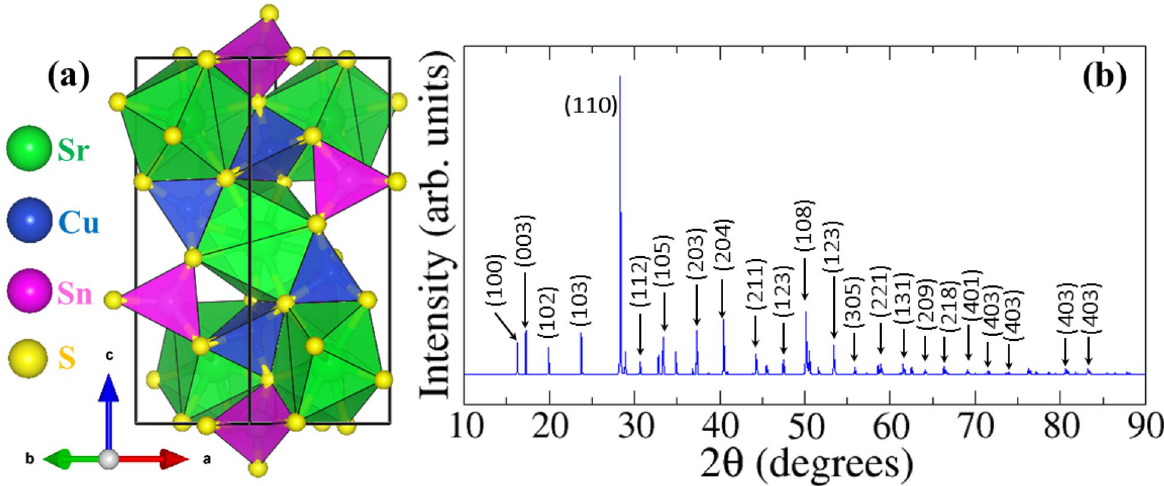
Figure 1. ( a ) Trigonal crystal structure produced by VESTA-ver.3.5.7 38 and ( b ) the corresponding simulated powder diffraction pattern of Cu 2 SrSnS 4 .